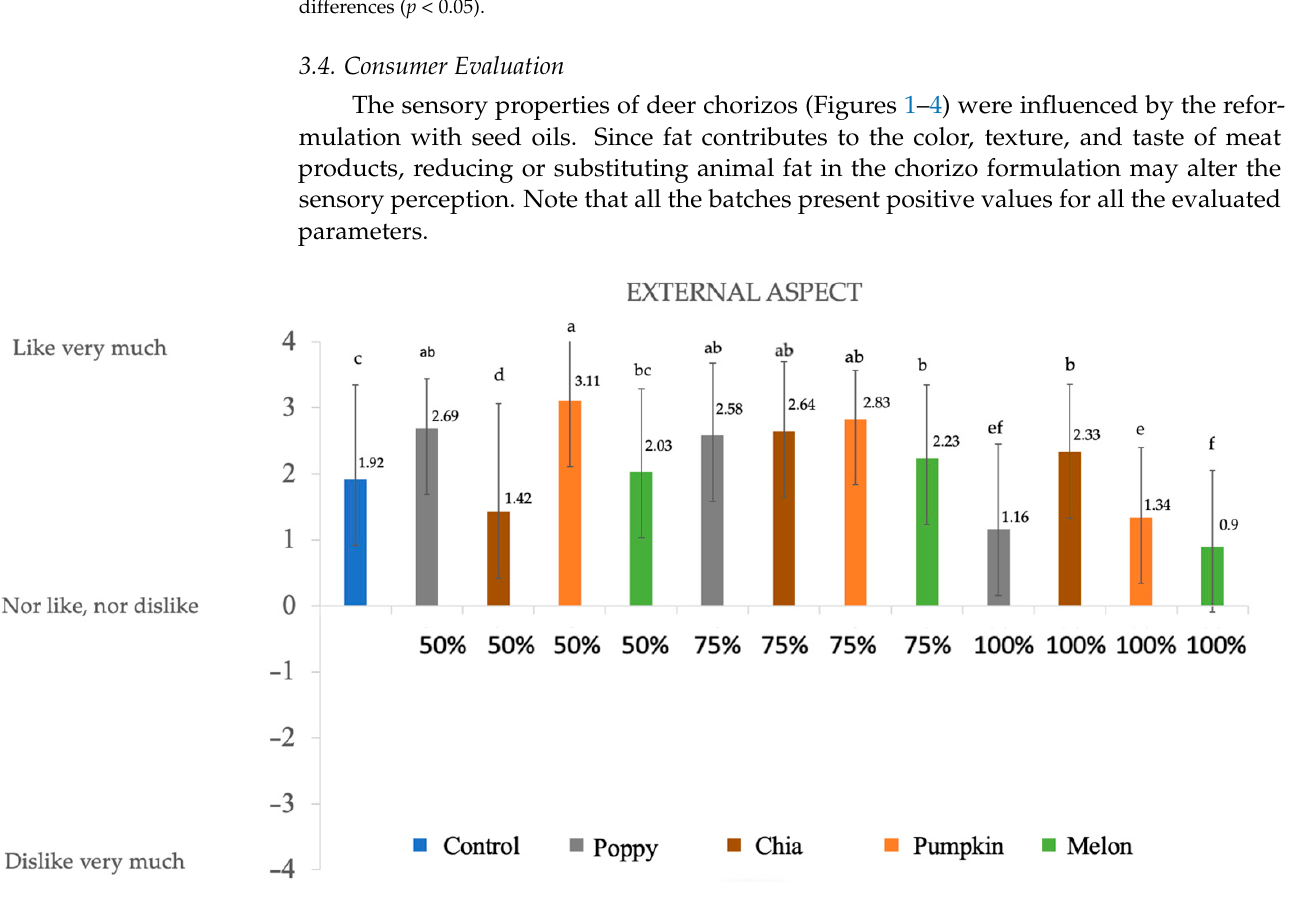
Figure 1. Results obtained in the sensory evaluation for external aspect. Numbers are mean ± standard error. Different letters in the same column for each attribute indicate statically differences ( p < 0.05).